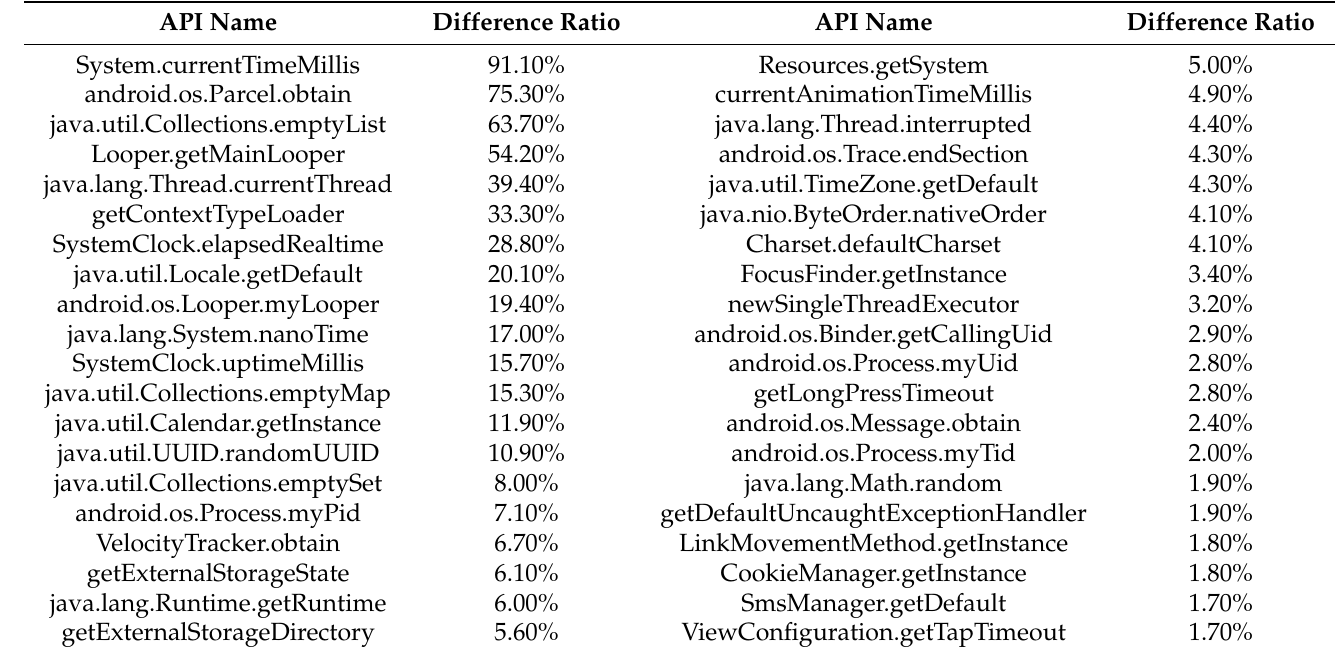
Table 4. Application Programming Interface (API) call frequency difference table for Android normal and malicious